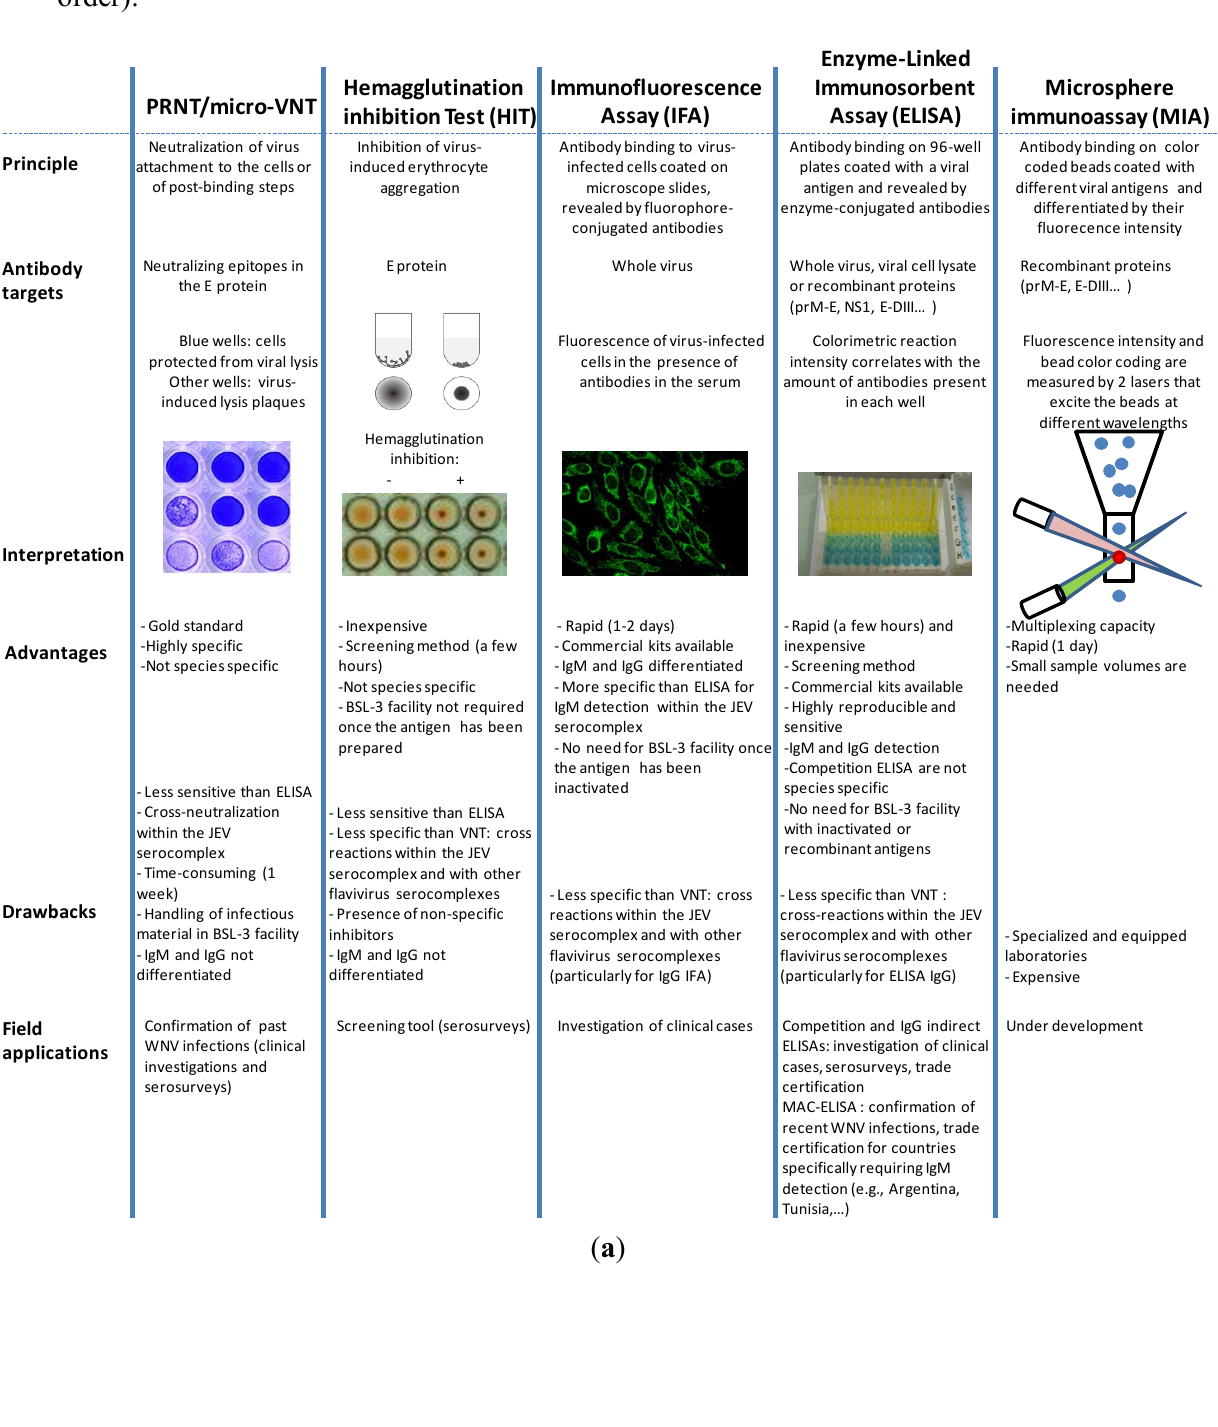
Figure 4. ( a ) Main serological tests used to diagnosis WNV ( b ) Illustrations of the three different ELISA methods: Competitive, indirect IgG, and MAC (the numbers indicate step